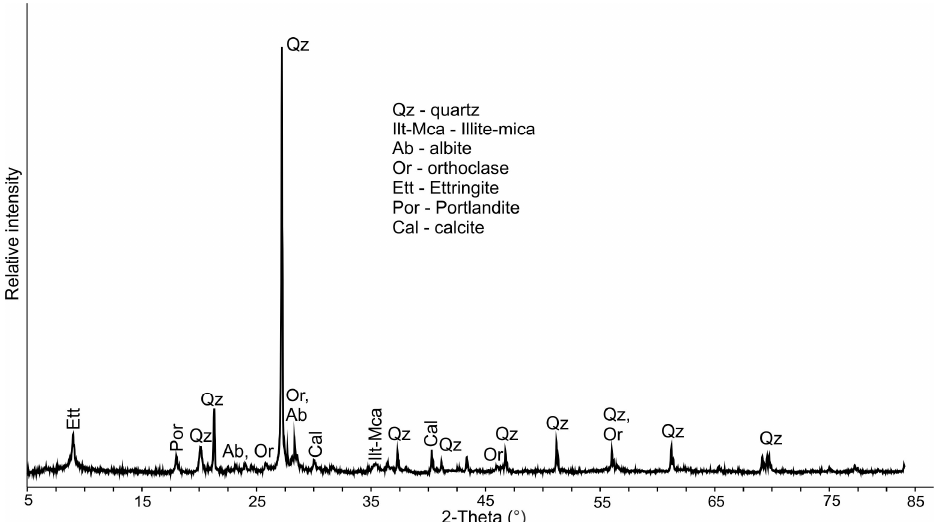
Figure 2. XRD result of unfired demolished mixed C&D waste.